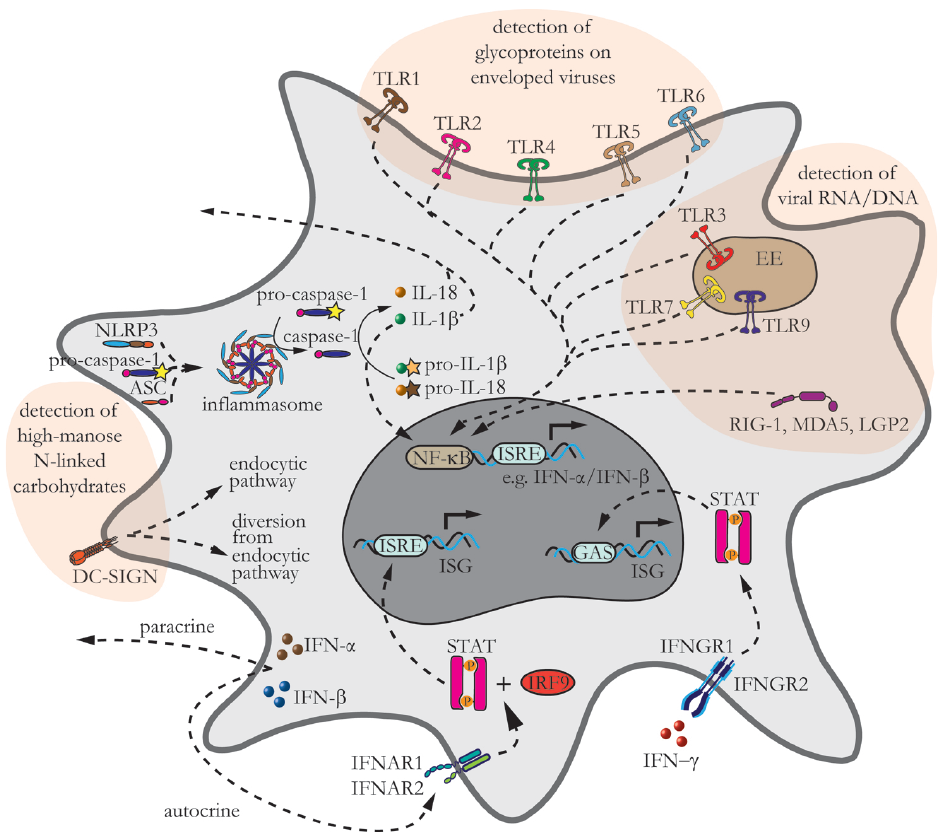
Figure 2. Astrocytes express several pattern recognition receptors (PRRs), which detect viral infection. The schematic depicts an astrocyte with a variety of PRRs engaged in triggering signaling cascades of the innate immune response. TLR1, TLR2, and TLRs 4-6, are located at the plasma membrane and detect glycoproteins on the viral envelope, whereas TLR3, TLR7, and TLR9 are located at the membrane of early endosomes. TLR3 detects double-stranded intermediate RNA (dsRNA), TLR7 detects single-stranded RNA (ssRNA), and TLR9 detects double-stranded DNA (dsDNA). RLRs are localized in the cytosol and sense viral RNA and DNA; they comprise RIG-I, melanoma differentiation-associated protein 5 (MDA5), and laboratory of genetics and physiology 2 (LGP2). Nucleotide oligomerization domain (NOD)-like receptors (NLRs) are another group of PRRs in the cytoplasm of astrocytes. NLRP3 contains pyrin N-terminal effector-binding domain (NLRPs), which together with pro-caspase-1 and ASC, make up the inflammasome; here, pro-inflammatory caspase-1 is converted to active caspase-1, which processes inactive interleukin (IL) precursors pro-IL-1 β and pro-IL-18 to their active forms IL-1 β and IL-18. IL-1 β and IL-18 are either secreted from cells or activate nuclear factor-kappa B (NF- κ B). CLRs are expressed at the cell surface, where they detect high-mannose N-linked carbohydrates on endogenous molecules and pathogens. Dendritic cell (DC)-specific ICAM-3 grabbing non-integrin (DC-SIGN) internalizes viruses that can either enter endocytotic pathway, ultimately resulting in viral degradation and antigen presentation, or can escape endocytic pathway. The CLR-related viral cycle in astrocytes has been poorly addressed thus far. PRR-triggered activation and translocation of IFN-regulatory factors (IRFs) and NF- κ B initiate the production of inflammatory cytokines and type I interferons (IFNs), IFN α / β . IFN α / β act in paracrine and autocrine ways via interferon receptors (IFNARs) through which they initiate signaling cascades, leading to the transcription of interferon-stimulated genes (ISGs) acting through IFN- stimulated regulatory elements. IFN- γ secreted by antigen-presenting cells further assists IFN α / β in clearing virus from the tissue. IFN- γ acts through interferon-gamma receptor (IFNGR) protein complex IFNGR1 and IFNGR2, initiating a signaling cascade on gamma interferon activation site (GAS) elements in the DNA, inducing cytokine